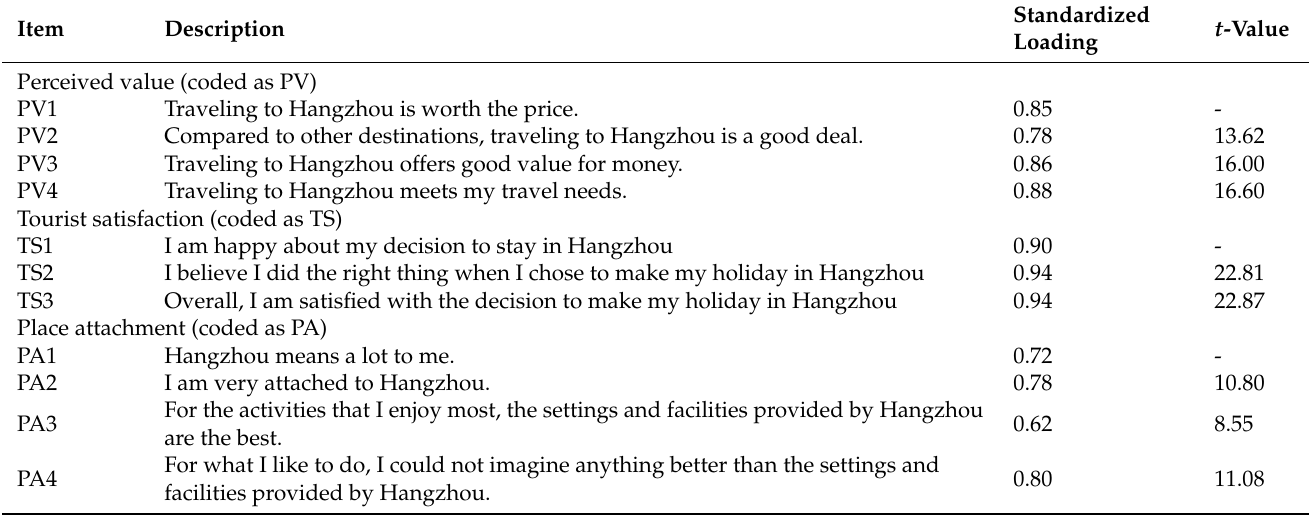
Table 1. Measurement and standardized loading